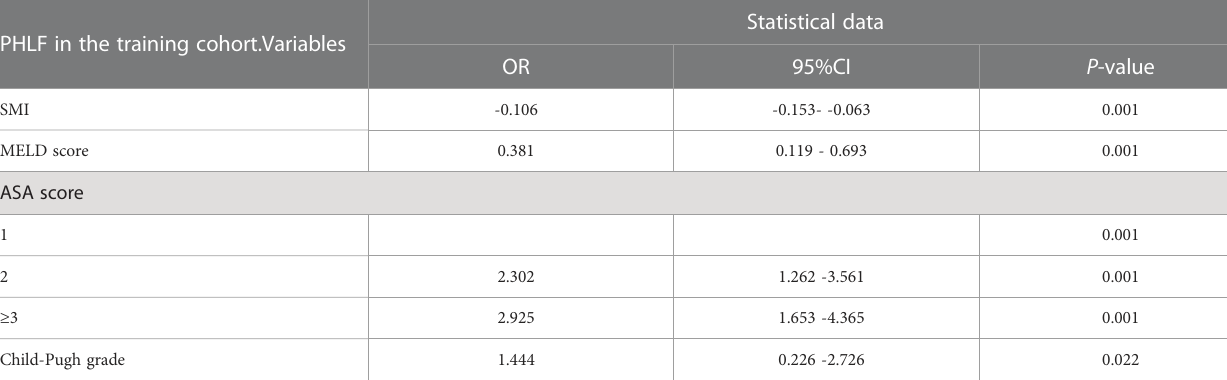
PHLF in the training